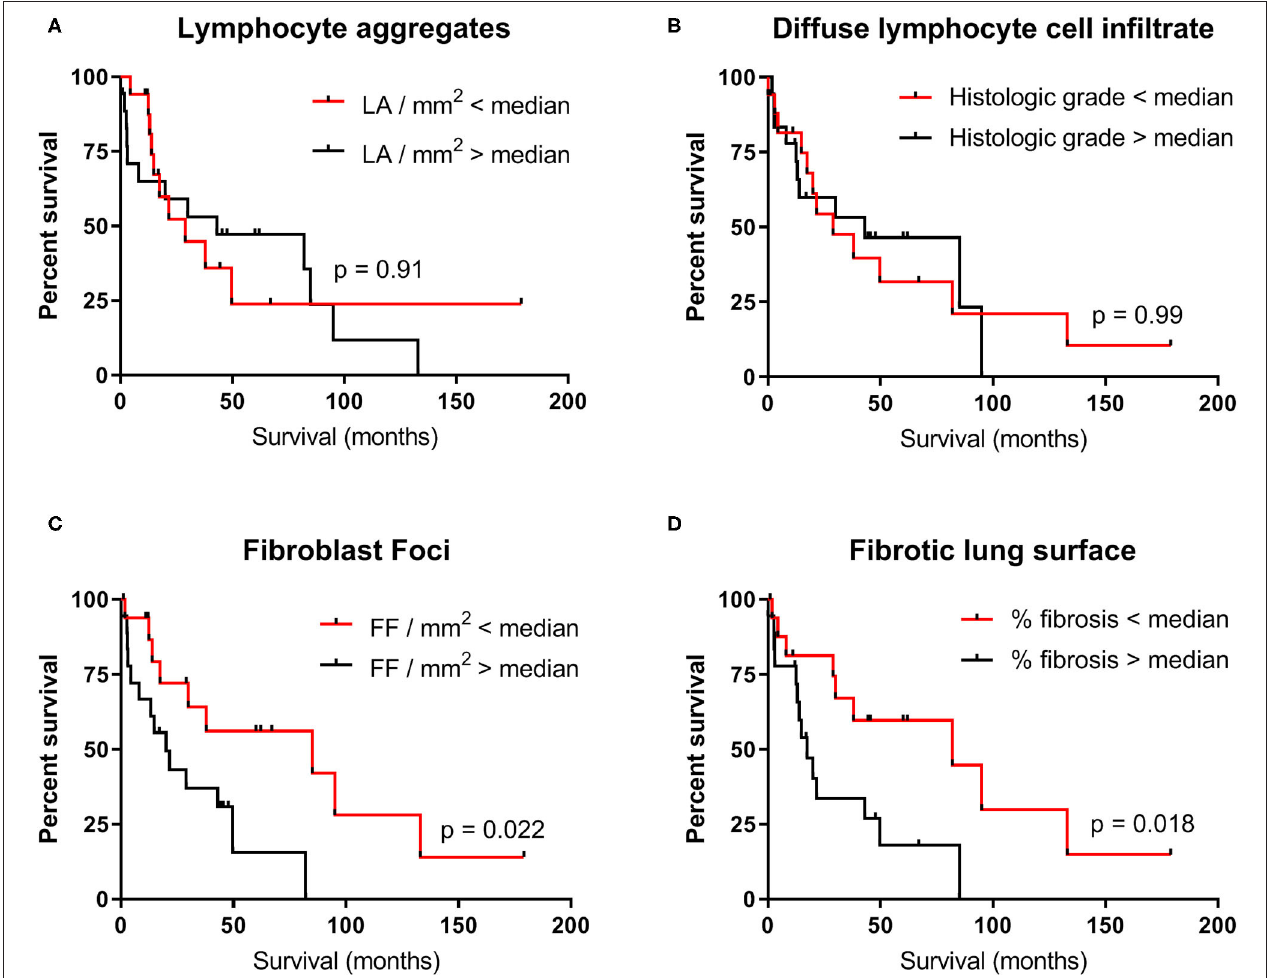
FIGURE 4 | Survival of the combined TERT-PF, SFTP-PF and sIPF patient cohorts. Kaplan–Meier curves showing the association between survival in months and the degree of (A) lymphocyte aggregates, (B) diffuse lymphocyte cell infiltrate, (C) fibroblast foci, and (D) fibrotic lung surface in 34 patients with pulmonary fibrosis. Median values of each parameter were used as cut-off. For the degree of lymphocyte aggregates and diffuse lymphocyte cell infiltrate, no significant differences were found between survival above (black line) and below median (red line). For the degree of fibroblast foci and fibrotic lung surface, the significant difference in median survival was respectively 65 months (85 vs. 20 months, p = 0.02) and 64.6 months (82 vs. 17.4 months, p = 0.02). Significances were calculated using Log-rank (Mantel–Cox) tests. LA, Lymphocyte aggregates; FF, Fibroblast